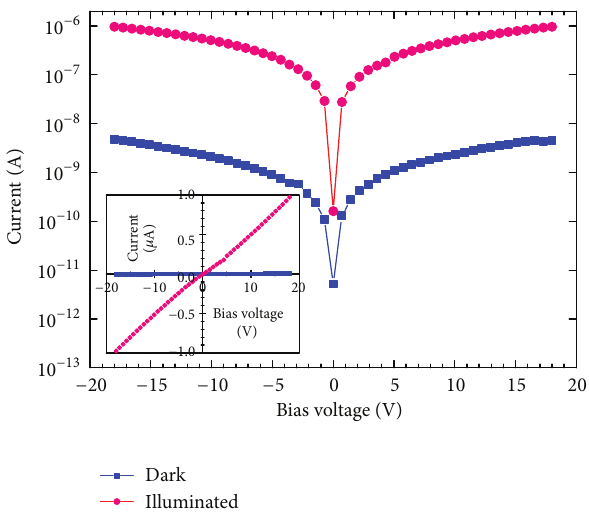
Figure 5: Dark and illuminated I - V characteristics of the Mg 0.52 Zn 0.48 O UV-PD. The inset shows the I - V characteristics on a linear scale.